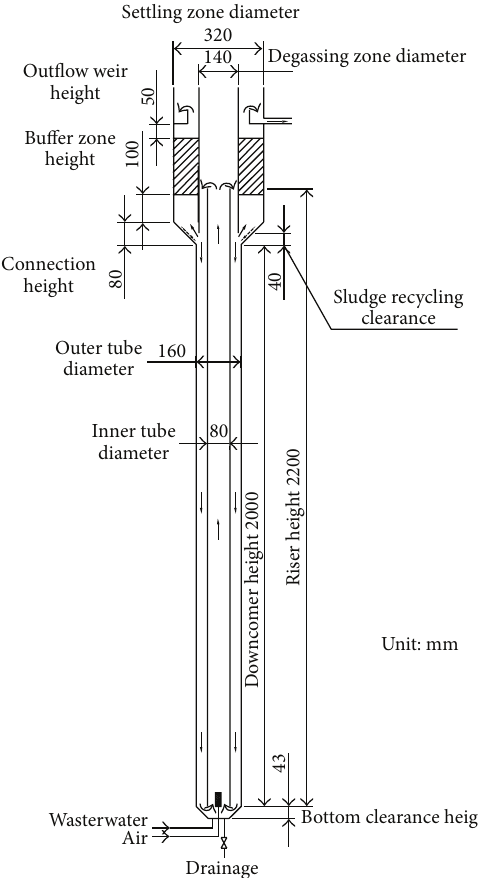
Figure 1: Schematic diagram of the experiment